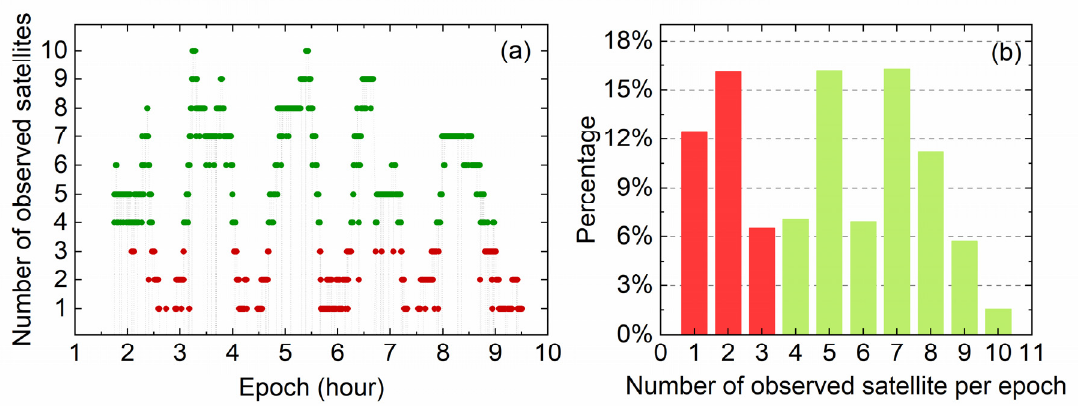
Figure 3. The number of observed satellites (left panel) and the statistic result (right panel).